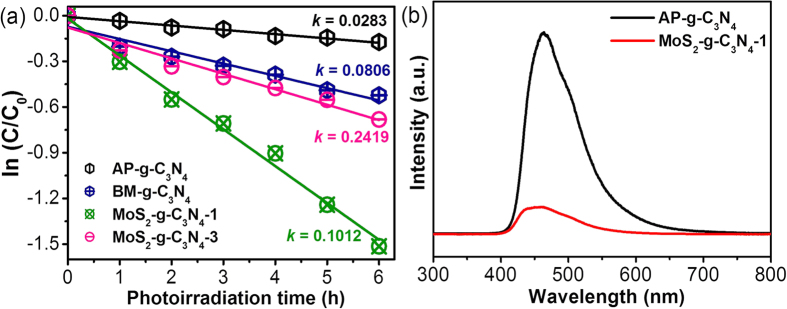
(a) Kinetic fit for the degradation of RhB over AP-g-C3N4, BP-g-C3N4, MoS2-g-C3N4-1 heterostructure, and MoS2-g-C3N4-3 heterostructure under visible photoirradiation and (b) PL spectra of AP-g-C3N4, and MoS2-g-C3N4-1 heterostructure.